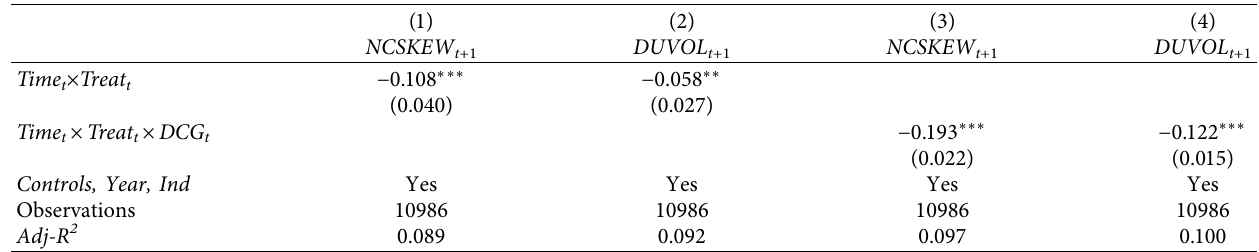
Table 8: Endogenous problems: